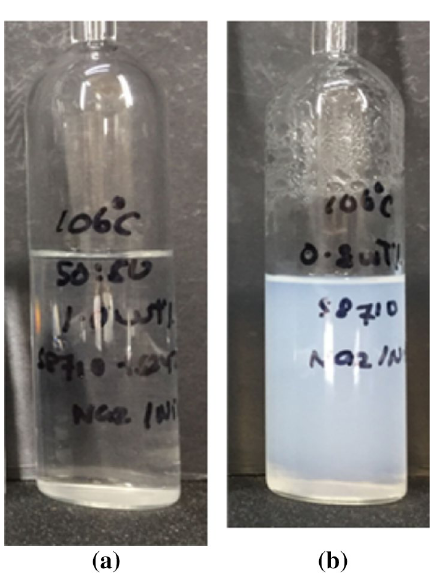
Fig. 9 Solubility test a clear surfactant solution and b cloudy sur- factant solution